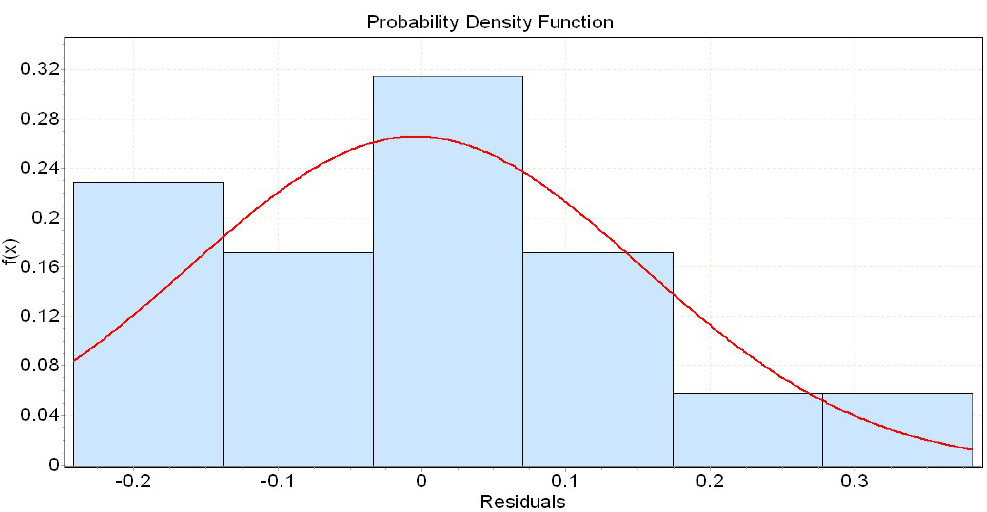
Figure 6. Normal probability